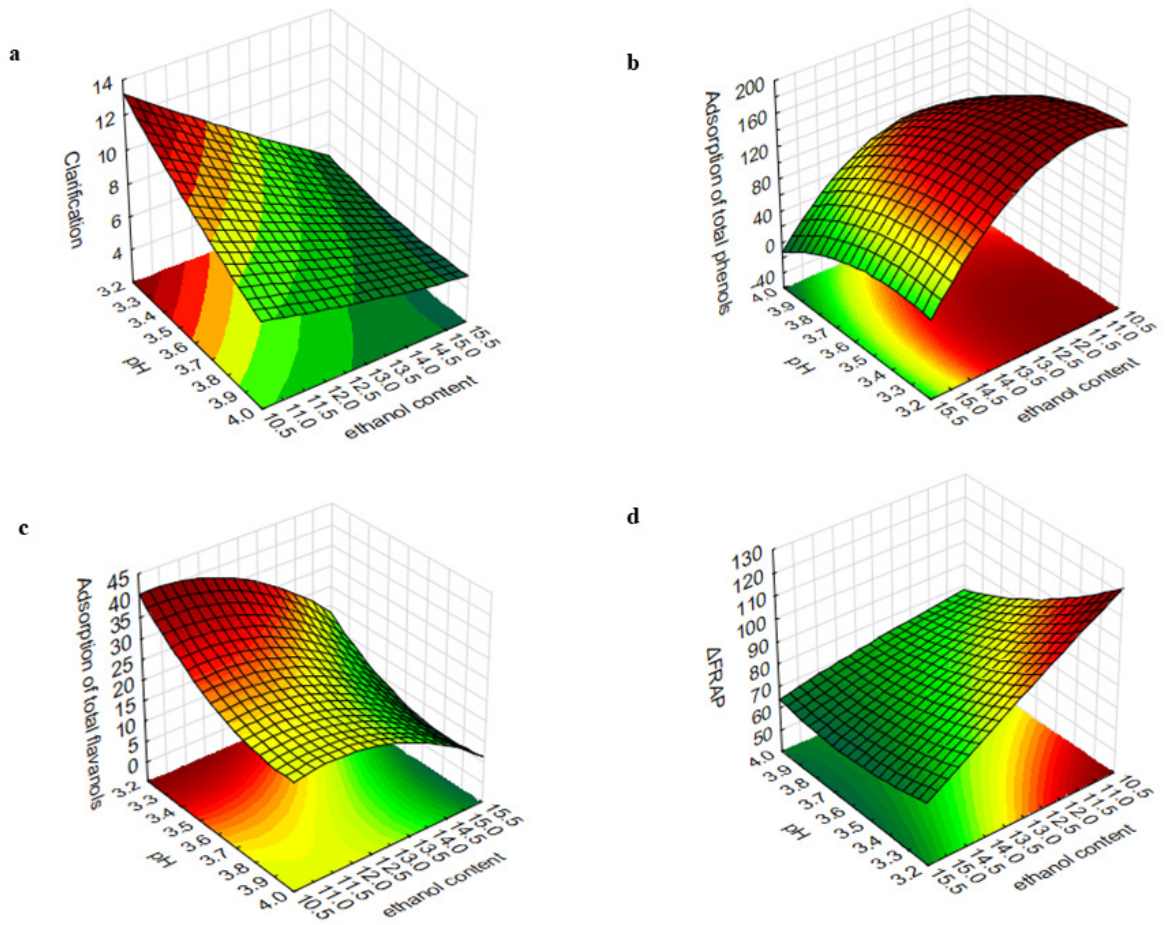
Figure 1. Influence of wine pH and ethanol content on ( a ) clarification (%), ( b ) adsorption of total phenols (mg/L), ( c ) adsorption of total flavanols (mg/L) and ( d ) Δ antioxidant activity determined by FRAP method (mg AAE/L).